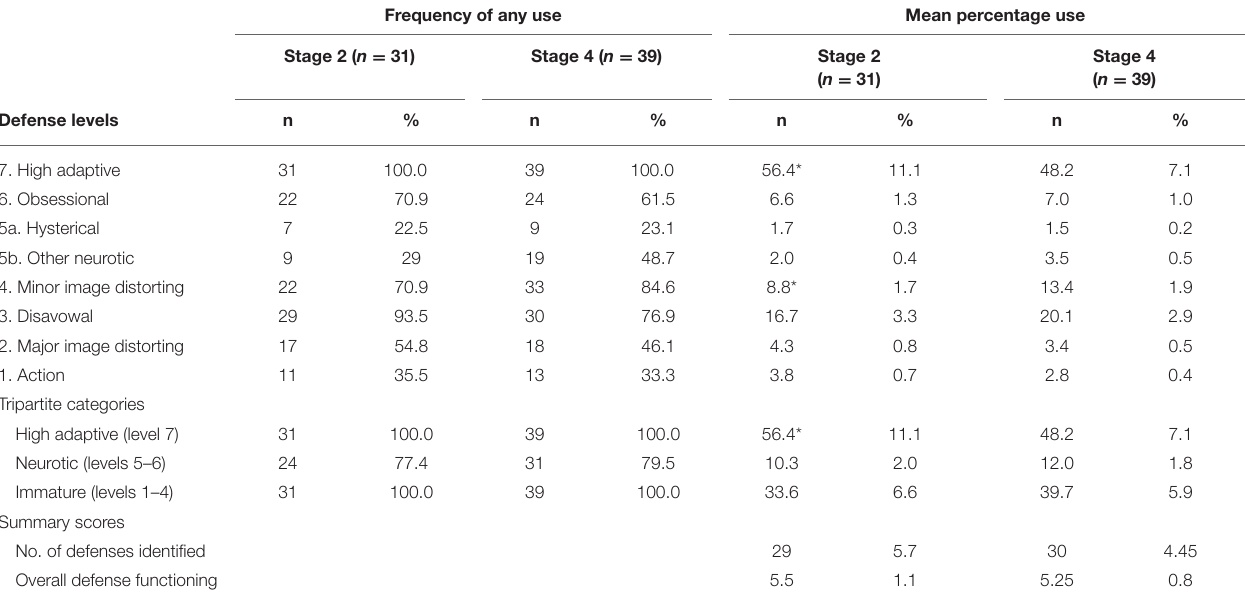
TABLE 2 | Prevalence of defense levels between women patients with stages 2 and 4